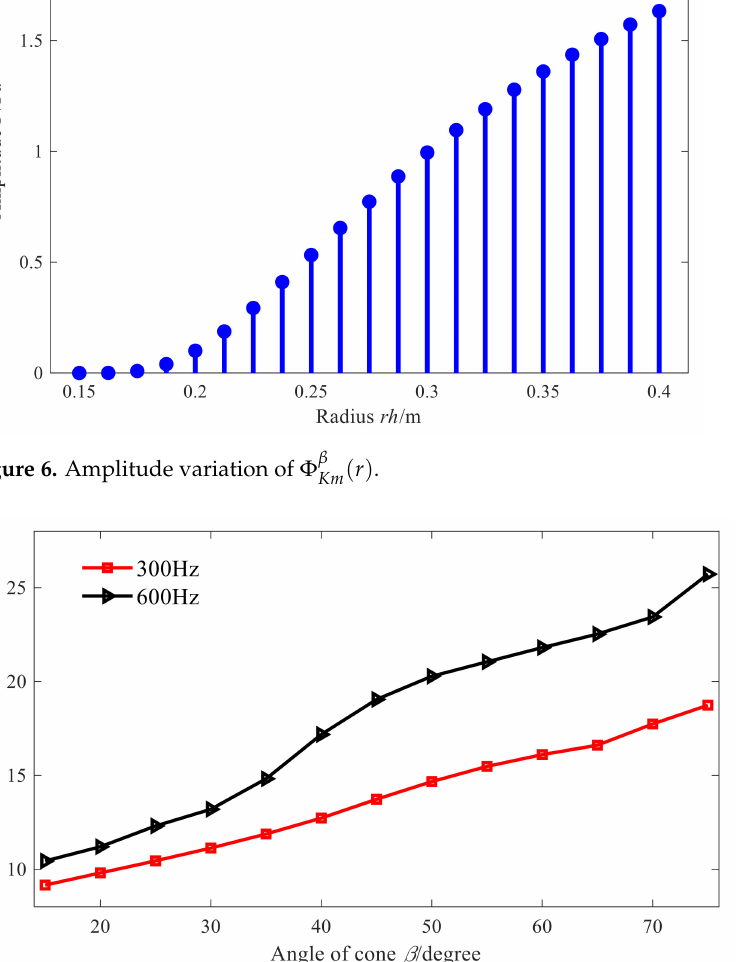
Figure 7. Overall errors of different